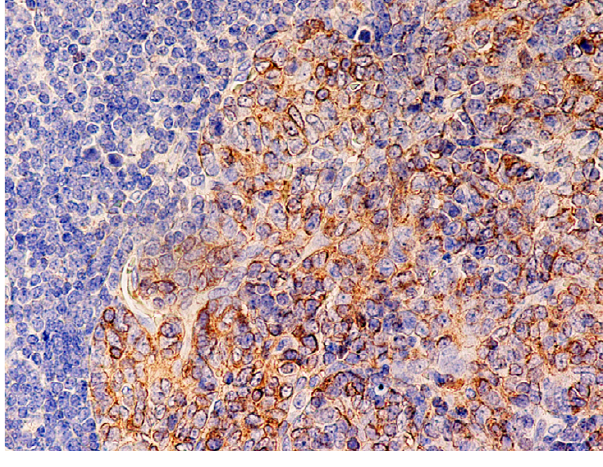
Figure 18 (B-SA, anti-CD57, × 400): Micronodular thymoma. Neoplas- tic epithelial cells express